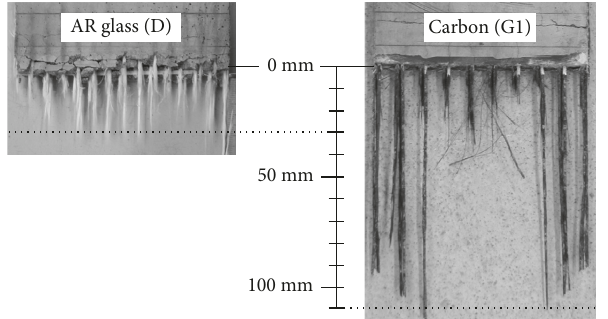
Figure 12: Effect of the fibre material on the textile’s development length.